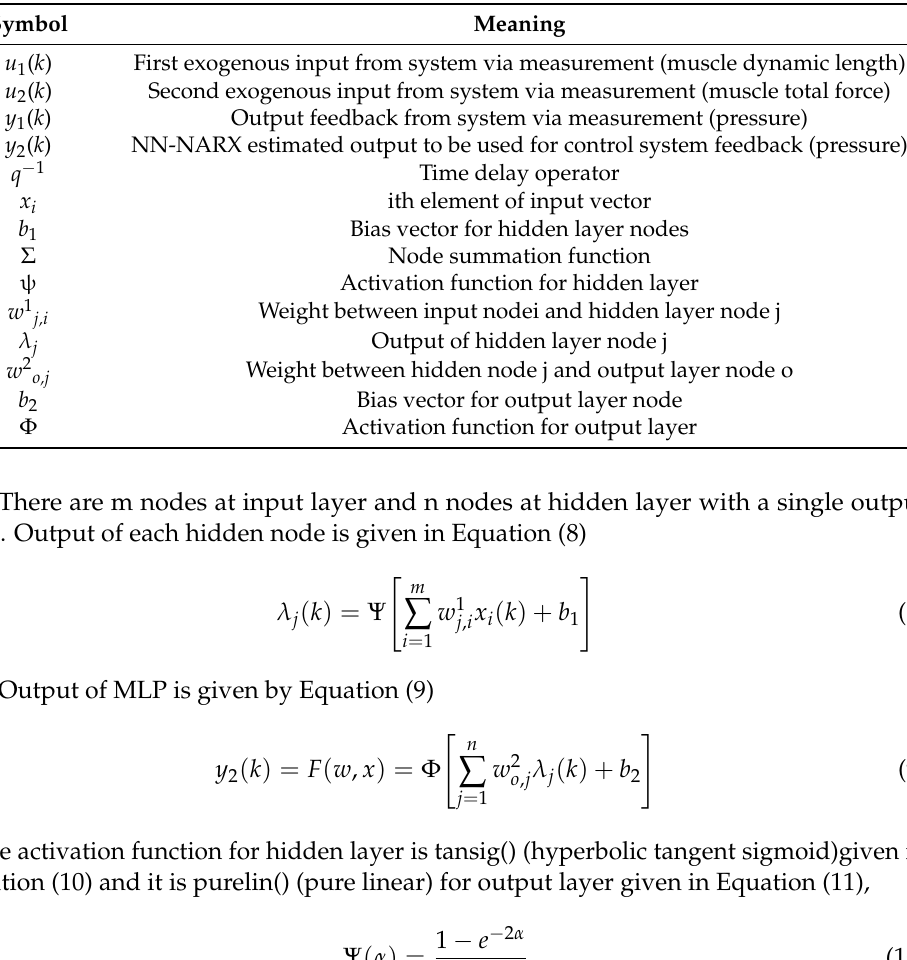
Table 4. Symbols used in MISO